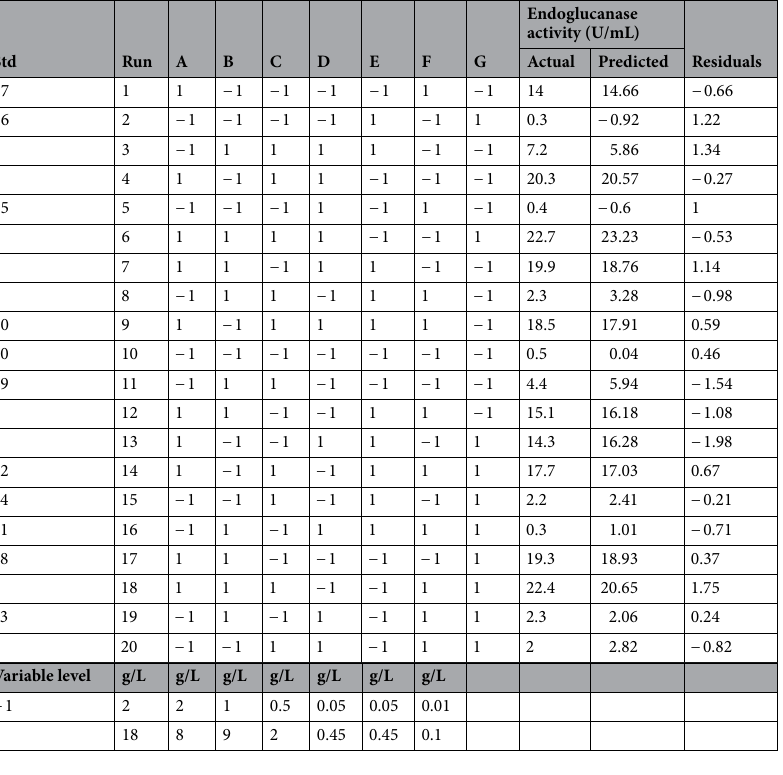
Table 1. Plackett–Burman experimental design matrix with the observed endoglucanase activity as affected by the seven independent variables. The independent factors are: A (CMC), B (Peptone), C (Yeast extract),